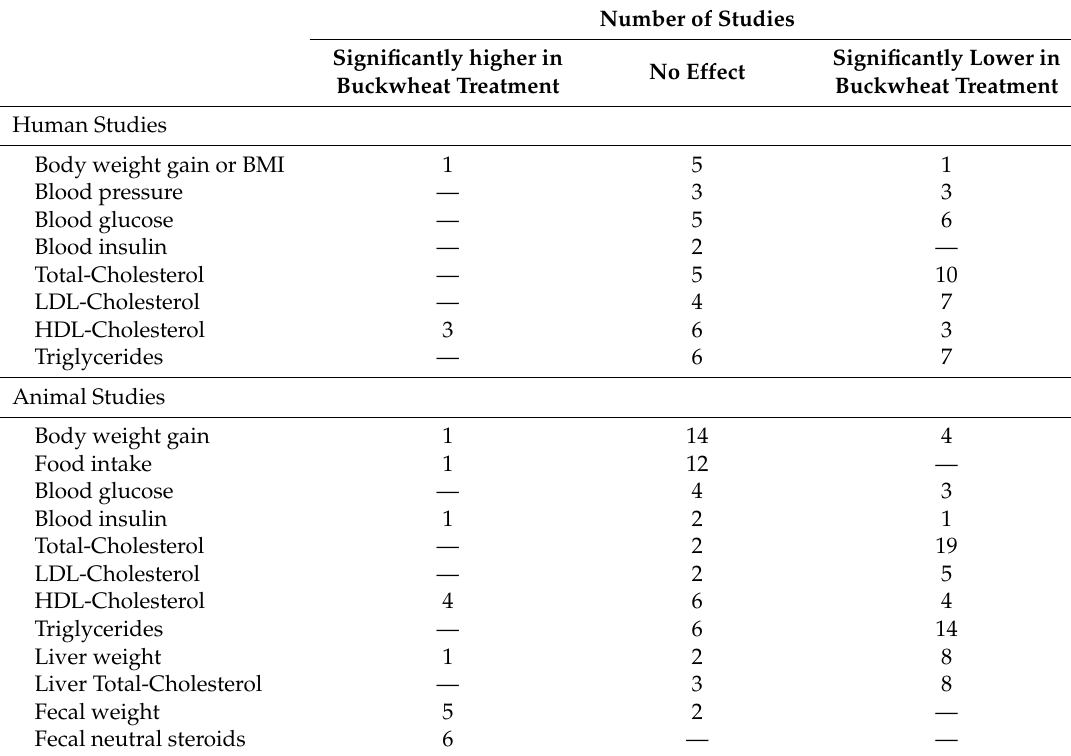
Table 3. The number of animal and human intervention studies showing significant increase, no effect and significant reduction on markers of CVD